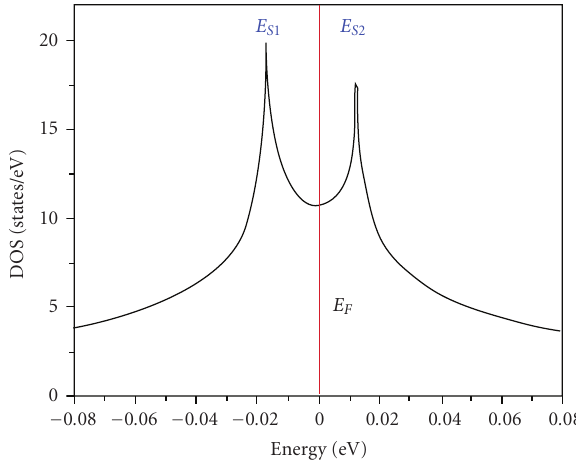
Figure 12: Density of States (DOS) in the orthorhombic